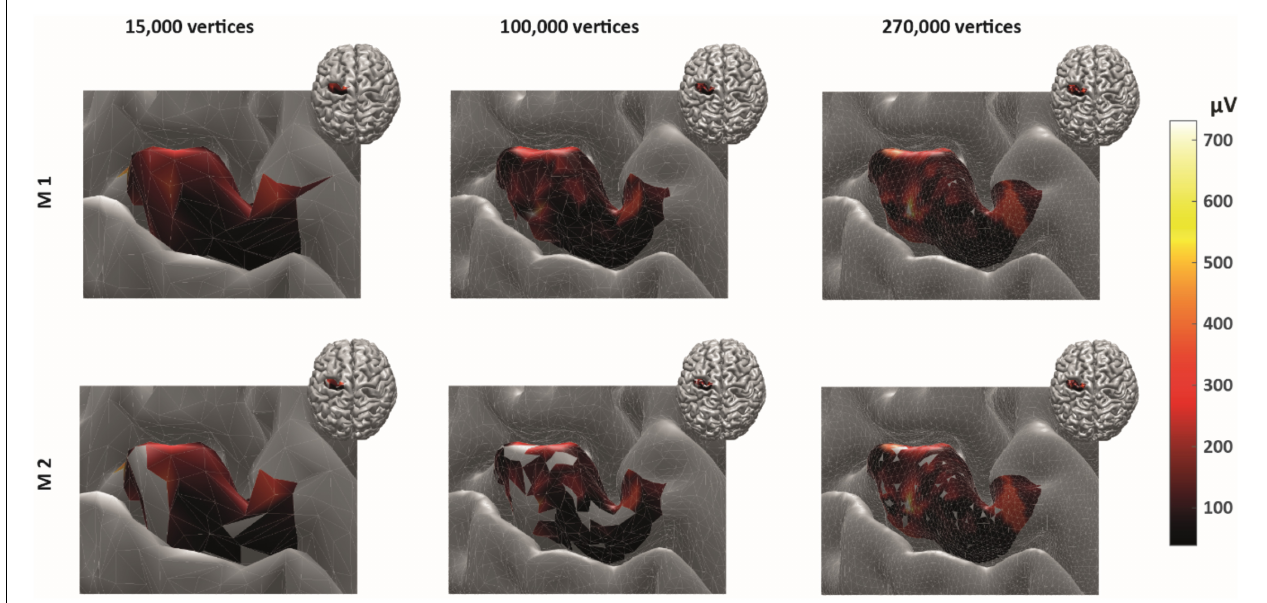
FIGURE 5 | The cortical representation for Session 1 intensity of 105% RMT of FCR in a representative participant. In M1 (upper row), we ignored non-MEP points, and in M2 (lower row), we removed them. Left: surface mesh resolution of 15,000 vertices; center: 100,000 vertices; right: maximum number of vertex number (in this participant, about 270,000 vertices). Color coding represents the value of the (interpolated) MEP-amplitude (in µ V). The effects of non-MEP point removal are especially visible at a lower resolution, but in all cases, removing these stimulation points cause the estimated area to